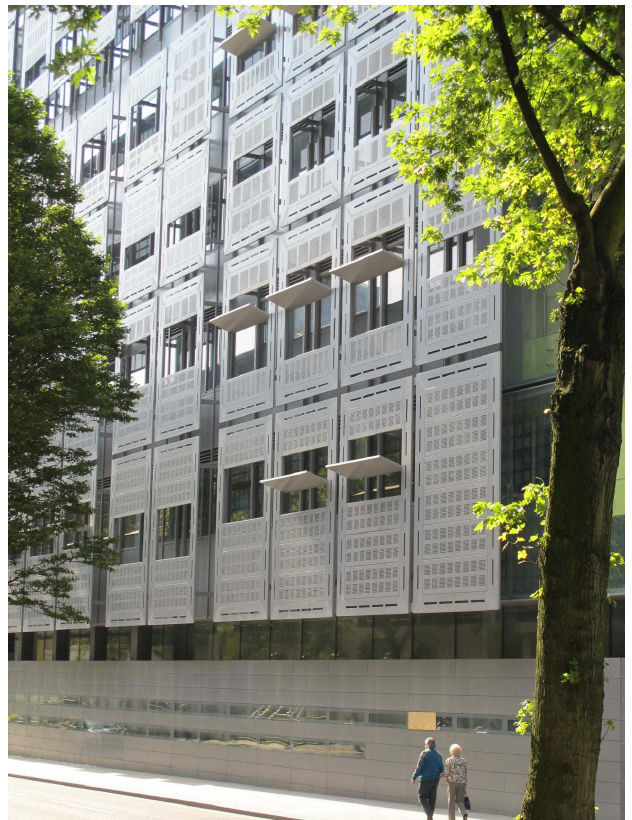
Figure 3. View of “Environmental Veil” (East